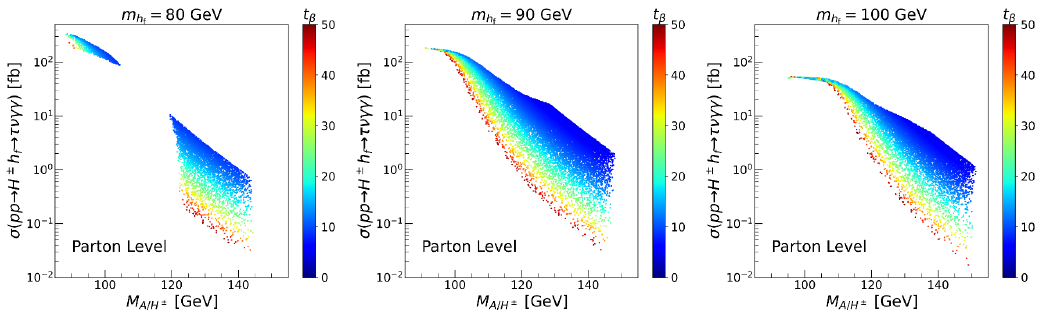
= 100 GeV (right). The color f